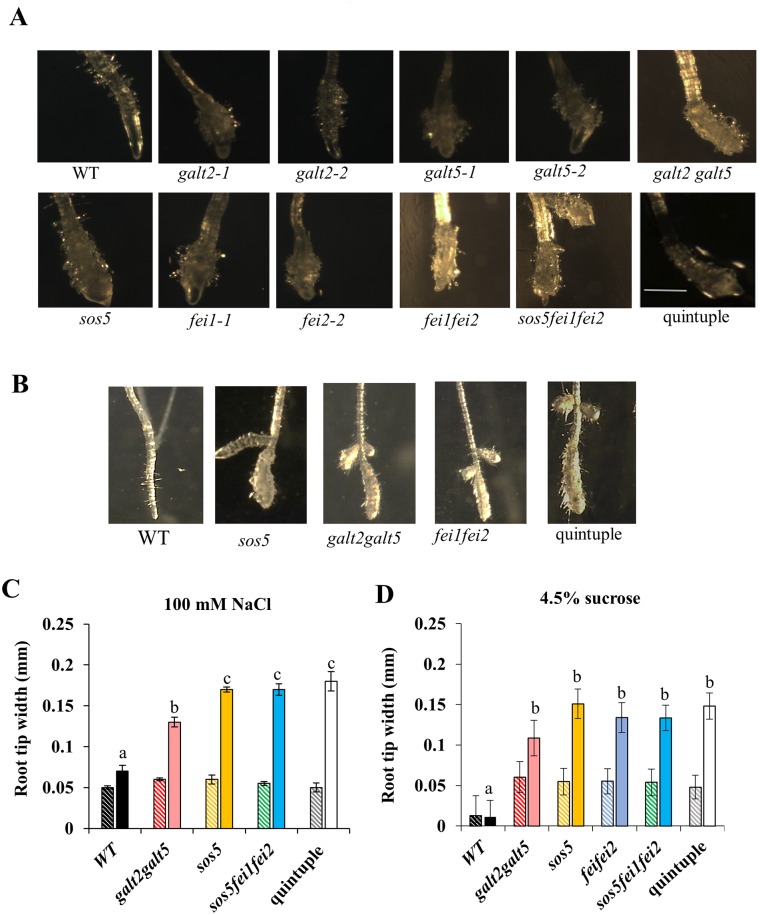
Quintuple mutants display a conditional root anisotropic growth defect (i.e., root swelling).(A) Root tips of WT and mutant seedlings four days after transfer from MS medium containing 1% sucrose to MS medium containing 100 mM NaCl as imaged by dark field microscopy. (B) Root tips of WT and mutant seedlings four days after transfer from MS medium containing 0% sucrose to MS medium containing 4.5% sucrose as imaged by dark field microscopy. (C) Graphical representation of root tip width in response to 100 mM NaCl. (D) Graphical representation of root tip width in response to 4.5% sucrose. The stripped bars indicate seedlings grown on control unsupplemented MS plates. Quantitation of root tip width was measured at the level of the youngest root hair using ImageJ software. Values are the means (n>15) ± SE. Different letters indicate statistically significant differences (P < 0.05) between means.